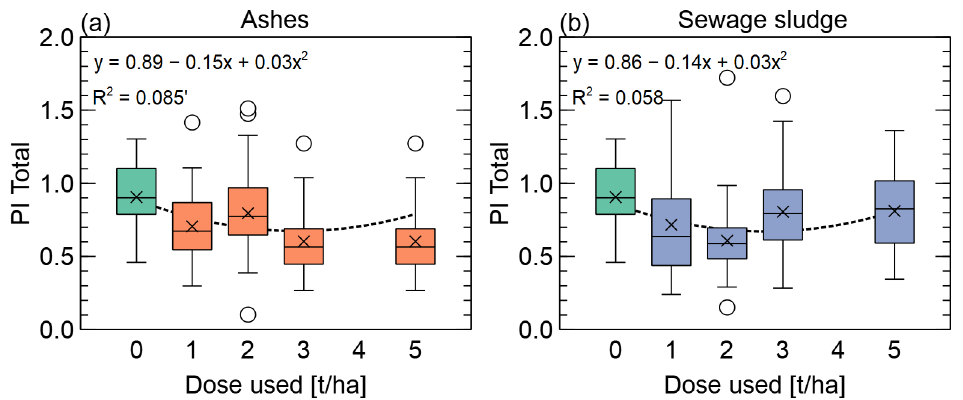
Figure 2. Photosynthetic efficiency (Performance Index total PI) versus used doses of preparations with phosphogypsum. Two studied variants of mixture with ashes ( a ) and sewage sludge ( b ) are presented. The dashed lines represent the linear regression fits of the data. The regression equations with the fitted parameters and the models’ R 2 values are printed in the subfigures. The regression parameters are statistically significant at p < 0.05. In the plot, boxes span from 1st to 3rd quantile, with the median indicated by a line, whiskers indicating 1.5 inter-quantile range, the × symbol mean value, and circles outlier observations.